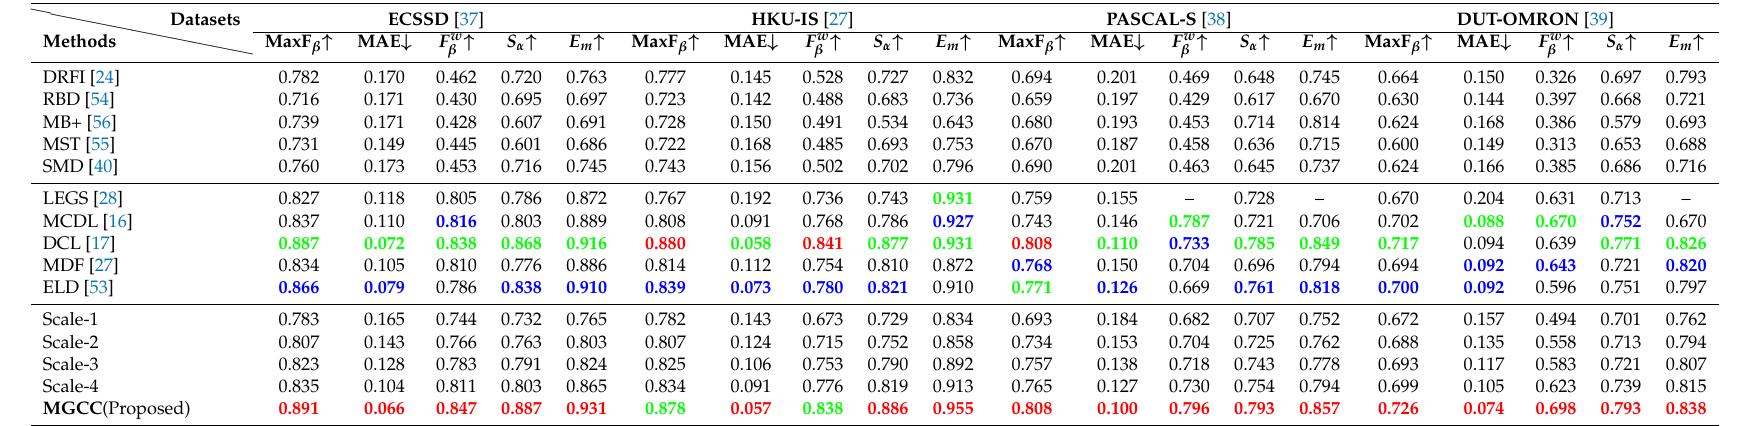
Table 2. Performance of the proposed MGCC and other 10 state-of-the-art methods on 4 popular datasets. Red , green and blue indicate the best, the second best and the third best performances. “–” represents no